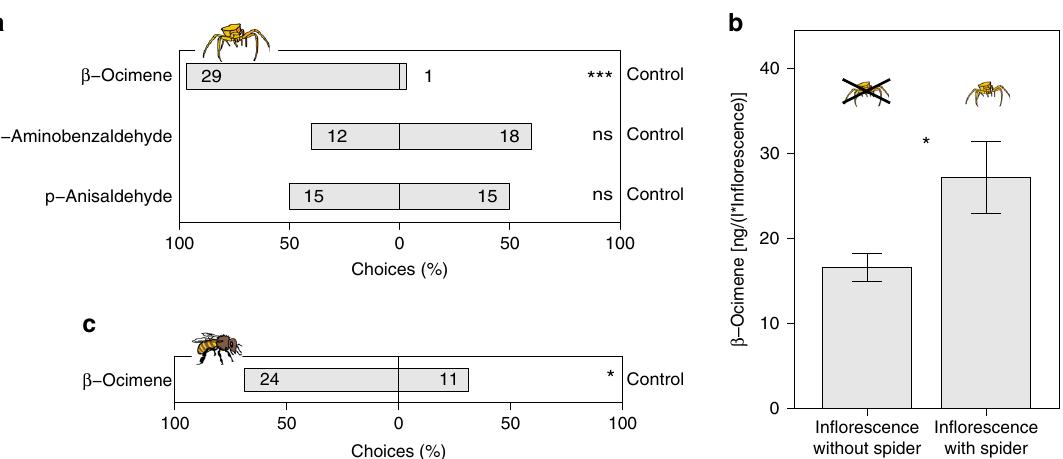
Fig. 2 Preferences for fl oral scent compounds in crab spiders and bees. a Dual-choice behavioral assays testing the preference of crab spiders for the three main fl oral volatiles emitted by Biscutella laevigata against an odorless control. Numbers in bars are the absolute numbers of crab spiders selecting either side. Binomial test: ns: P > 0.05, * P < 0.05, ** P < 0.01, *** P < 0.001. b Emission of β -ocimene in plants with and without crab spiders hunting on in fl orescence of B. laevigata in the Swiss lowland population ( N = 94). Each bar represents a mean ± s.e., signi fi cant differences between treatments are indicated by an asterisk. c Dual-choice behavioral assays testing the preference of bees for B. laevigata plants with augmented emission of β -ocimene against a control plant. Numbers in bars are the absolute number of landings on in fl orescences. Binomial test: ns: P > 0.05, * P < 0.05, ** P < 0.01, *** P < 0.001